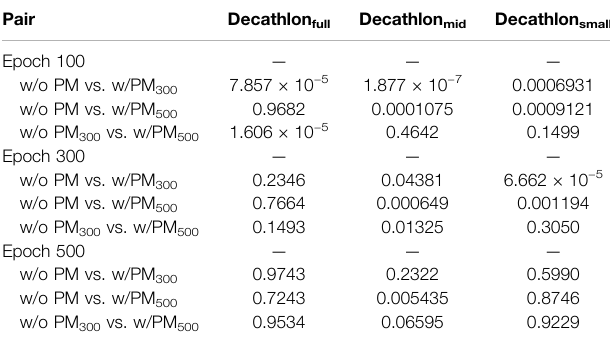
TABLE 5 | p -values for differences of DSC in Decathlon full , Decathlon mid , and Decathlon small .